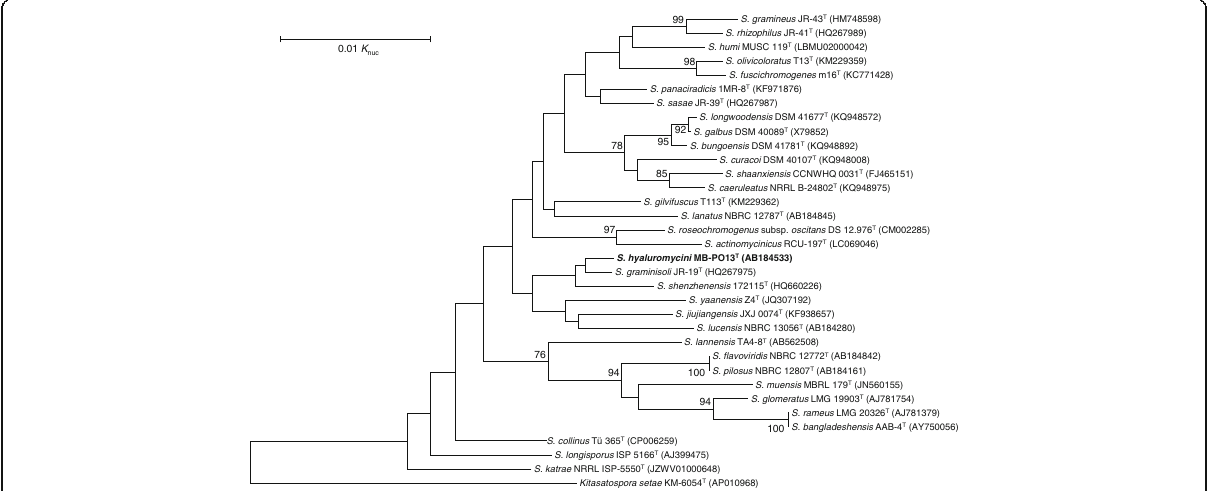
Fig. 2 Neighbor-joining phylogenetic tree based on 16S rRNA gene sequences of strain MB-PO13 T and its taxonomic neighbors. Kitasatospora setae KM-6054 T (AB022868) was used as the outgroup. Bootstrap values (>70%) based on 1000 replicates are shown at branch nodes. Bar, 0.01 substitutions per nucleotide position